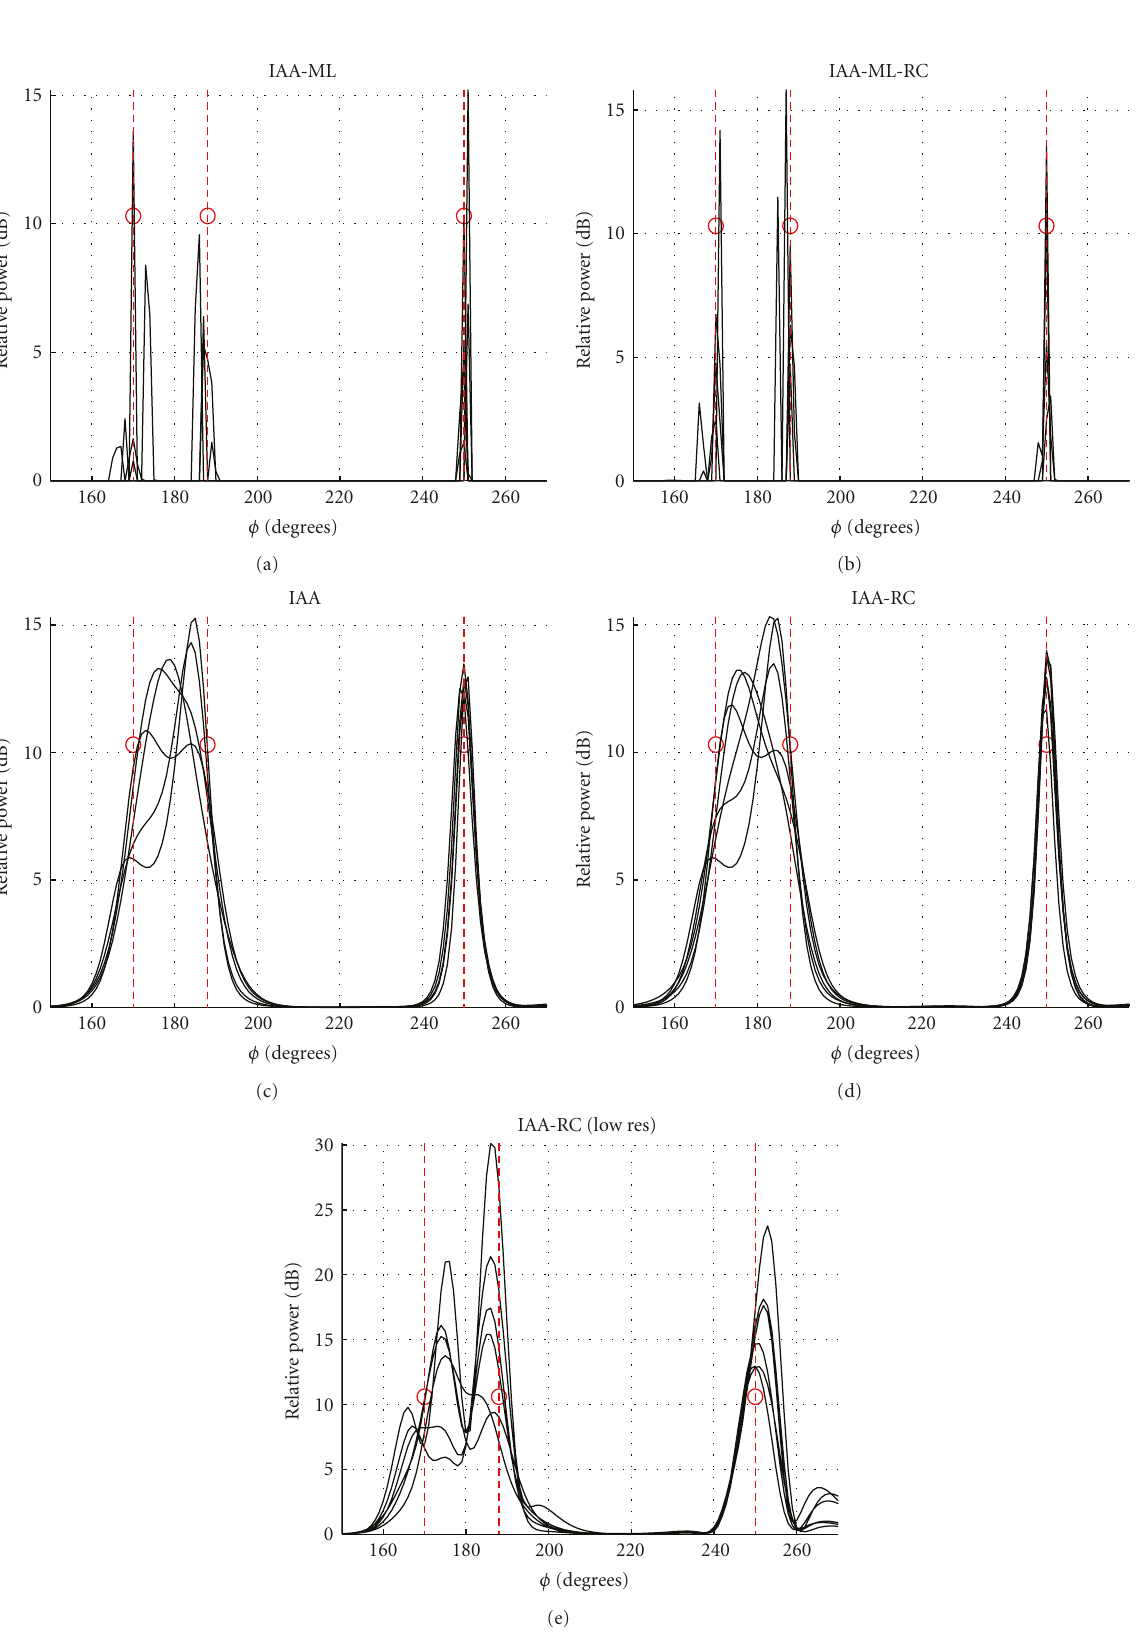
Figure 7: Spatial estimates of the di ff erent beamforming solutions (rectangular array, θ 1 = 45 ◦ , φ 1 = 170 ◦ , θ 2 = 45 ◦ , φ 2 = 188 ◦ , θ 3 = 45 ◦ , φ 3 = 250 ◦ , N = 3 snapshots, SNR 1 = SNR 2 = SNR 3 = 10dB, noise power equal to 0dB, and f c =